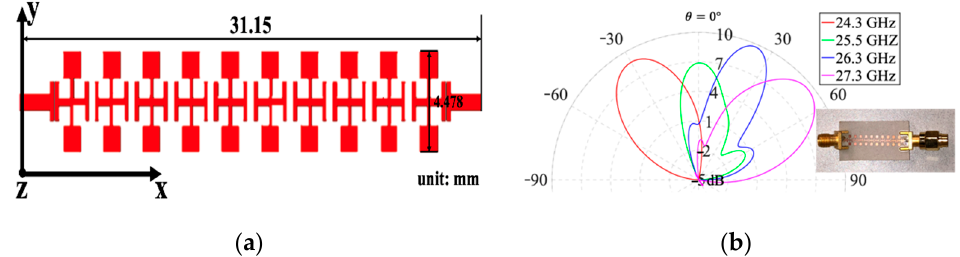
Figure 5. ( a ) Layout of 1D metamaterial leaky wave antenna (MTM LWA) at 24 GHz band; ( b ) its radiation pattern [49].